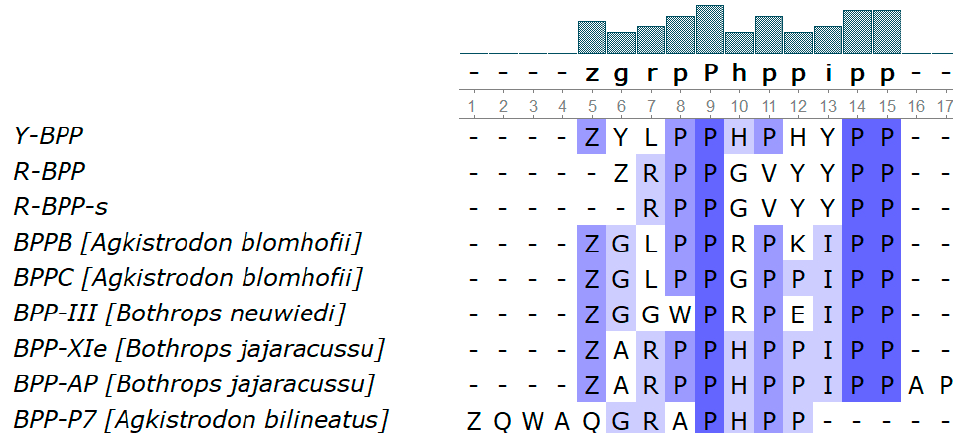
Figure 6. Amino acid sequences of C-type natriuretic precursors deduced from DNA sequences. Azemiopsin—yellow, Y-BPP—lilac, R-BPP and its Lys-analog—light green, putative shortened R-BPP